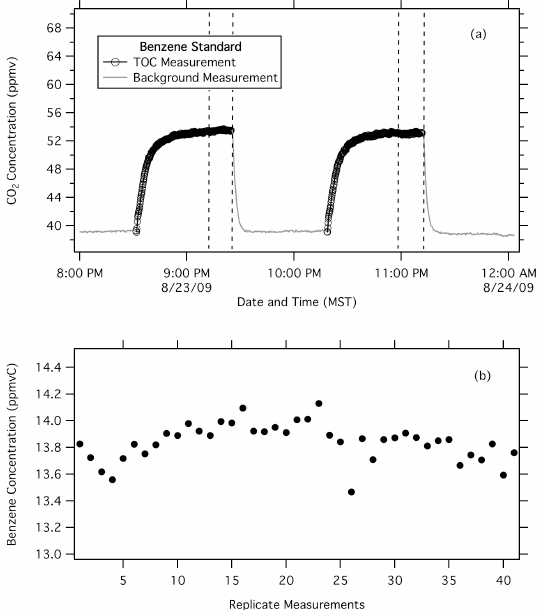
Figure 3. CO 2 measurements showing two complete cycles of background and TOC measurement of a benzene standard generated by MOCCS, Fig. 3a. The TOC measurements are shown in black with open circles and the background measurements are shown in grey. Subtracting the interpolated background and dividing the result by the number of carbon atoms in a benzene molecule (6) gives the benzene concentration from the permeation source. After the signal stabilizes, an average of the measured signal minus background is taken (shown as the data between the dashed line). Shown in Fig. 3b are replicate measurements of the benzene concentration made over the course of five days. The average concentration over this time period (38 cycles) was determined to be 13.8 ± 0.1 ppmv of carbon (ppmvC).